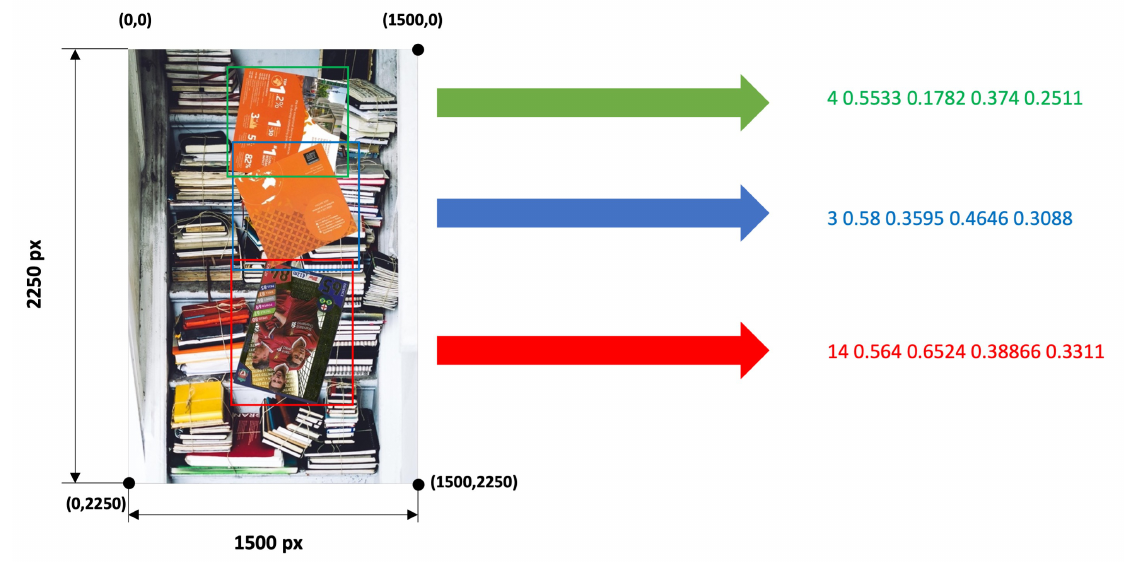
Figure 10. Examples of formats representing coordinates of a bounding box in YOLO